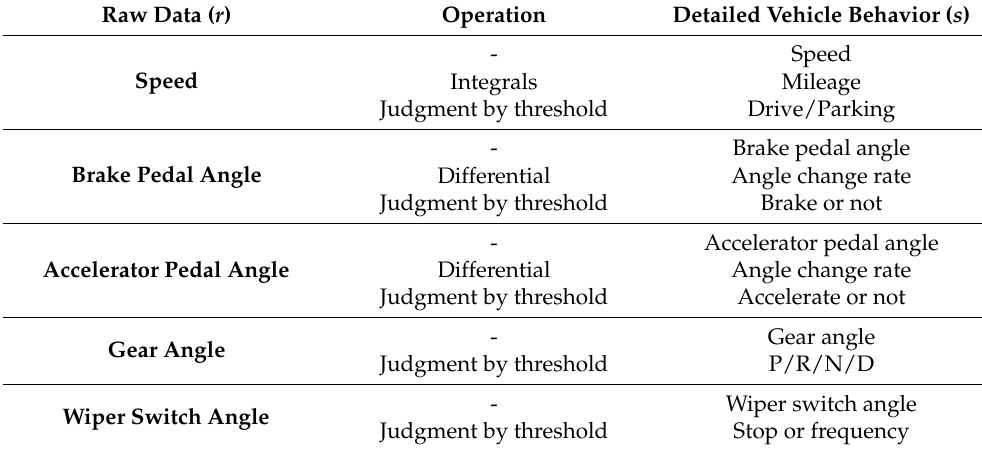
Table 3. Methods and results of raw data